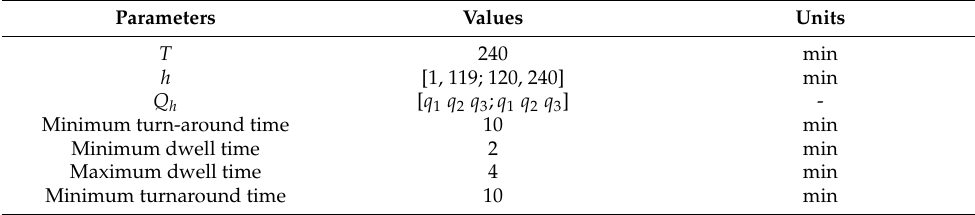
Table A3. Values of time